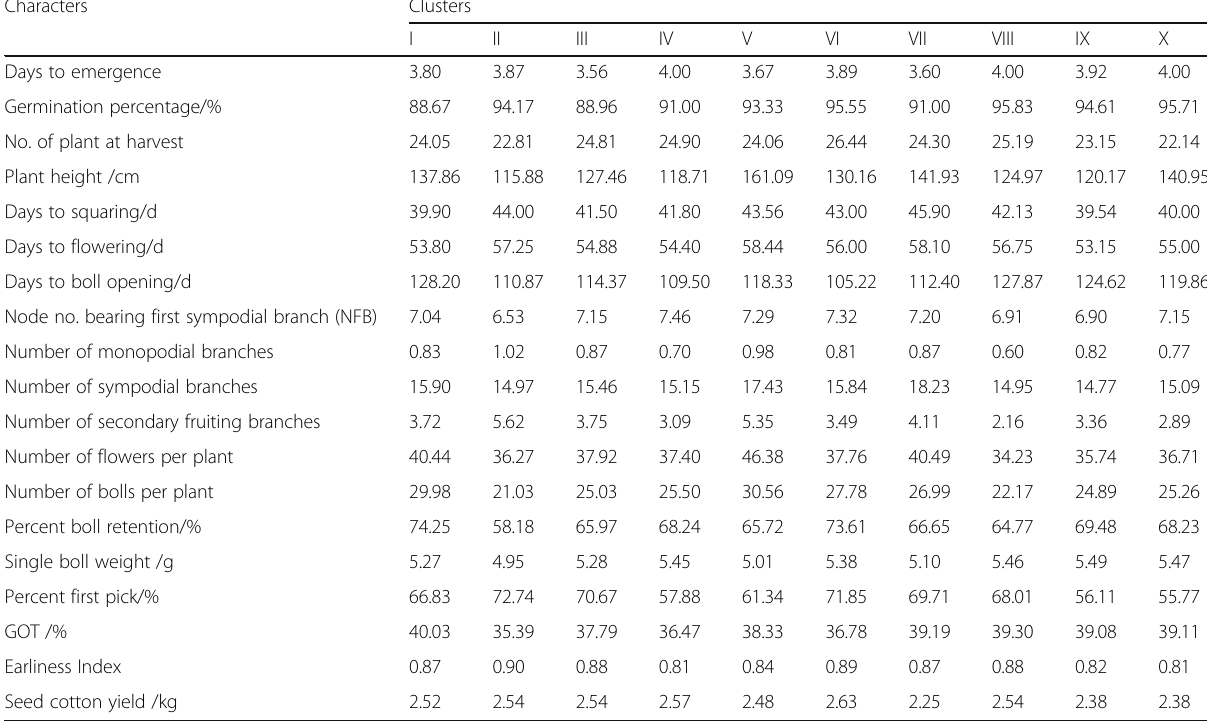
Table 4 Cluster mean for 19 characters in 100 cotton genotypes